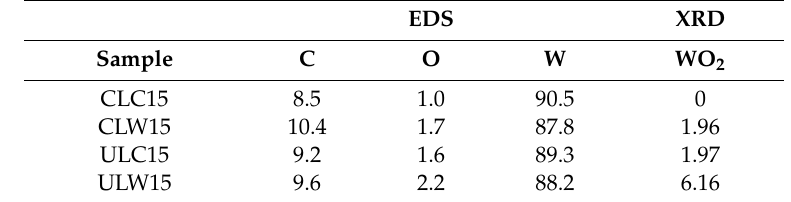
Table 2. Content of carbon, oxygen and tungsten, determined by EDS, and content of WO 2 , determined by XRD, on the fracture surfaces (wt%).